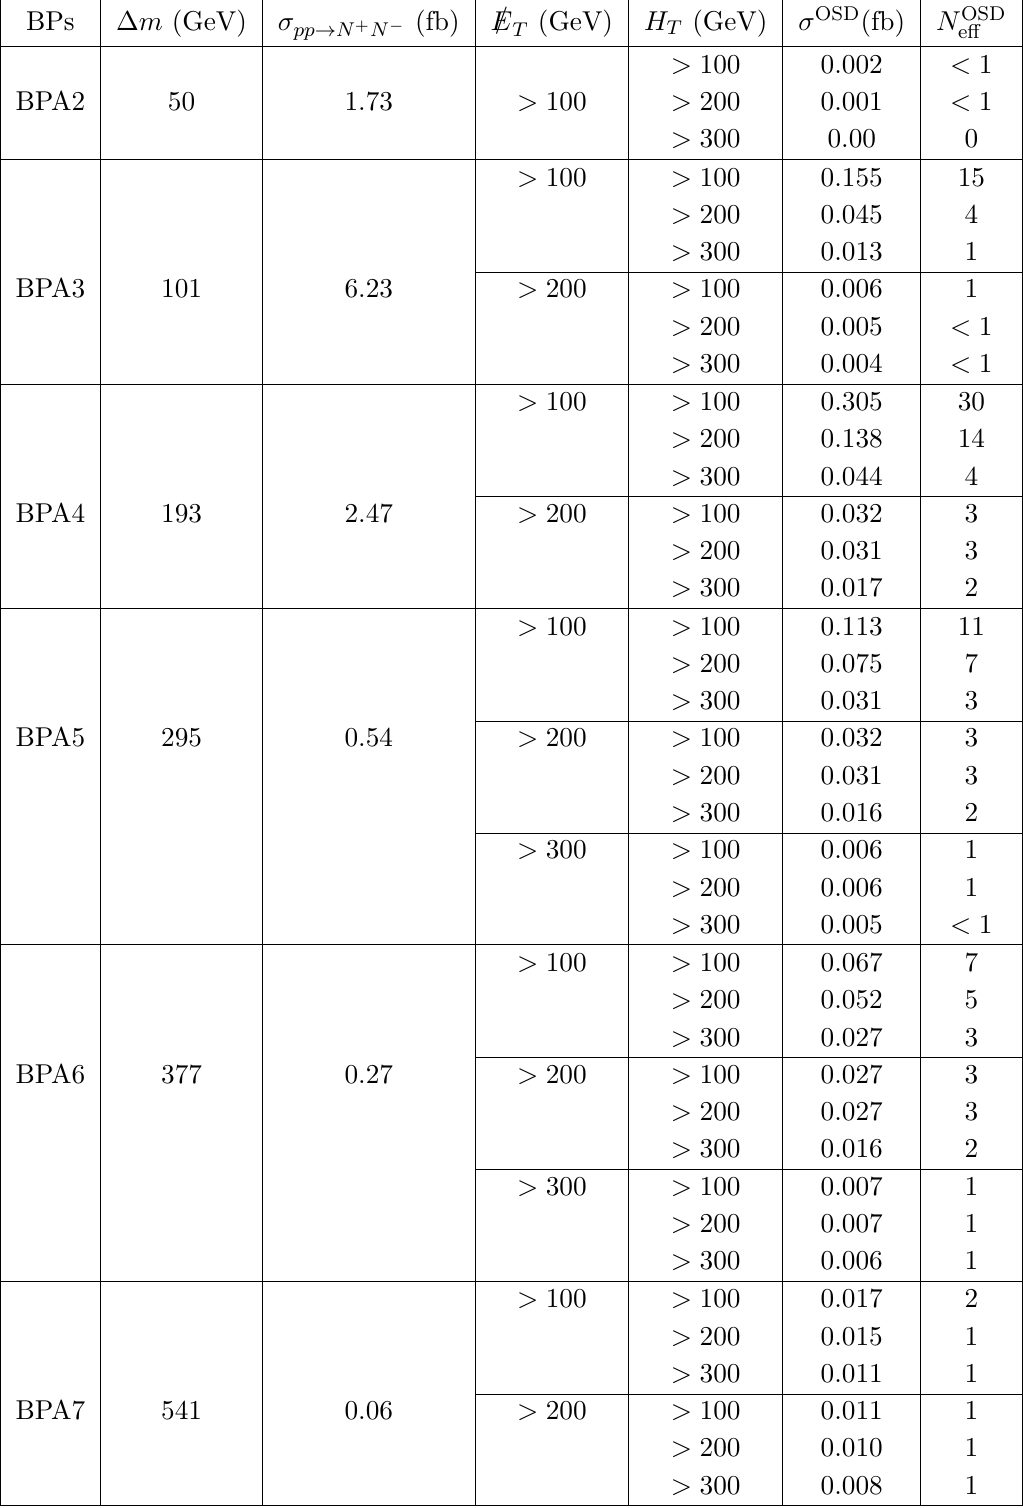
Table 4 . Signal events for few selected benchmark points (BPA2-BPA7, see table 2) with p s